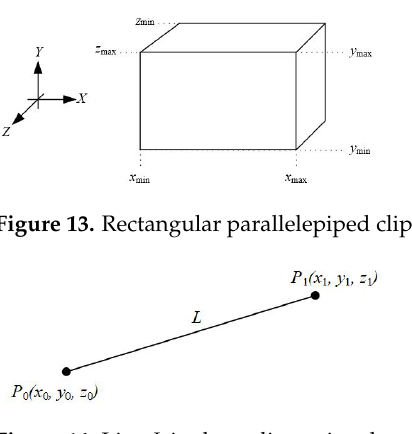
Figure 14. Line L in three-dimensional space.